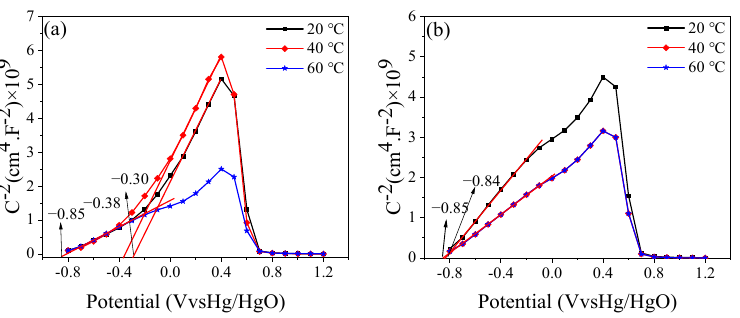
Figure 9. MS curve of Q235 steel: ( a ) 0.5 h and ( b ) 240 h.